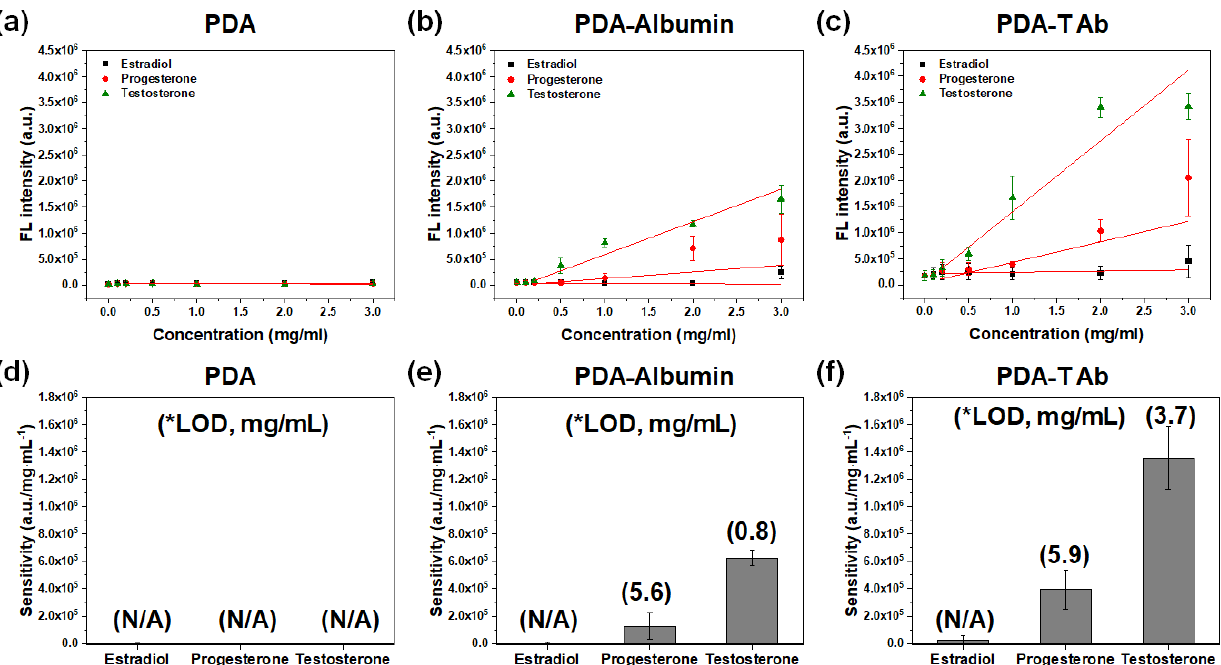
Figure 5. Fluorescence (FL) intensity of ( a ) PDA, ( b ) PDA-Albumin and ( c ) PDA-T Ab after incubation with sex steroid hormones ( β -estradiol, progesterone and T). Sensitivity of sensing platforms based on ( d ) PDA, ( e ) PDA-Albumin and ( f ) PDA-T Ab for each sex steroid hormone. * LOD: limit of detection.